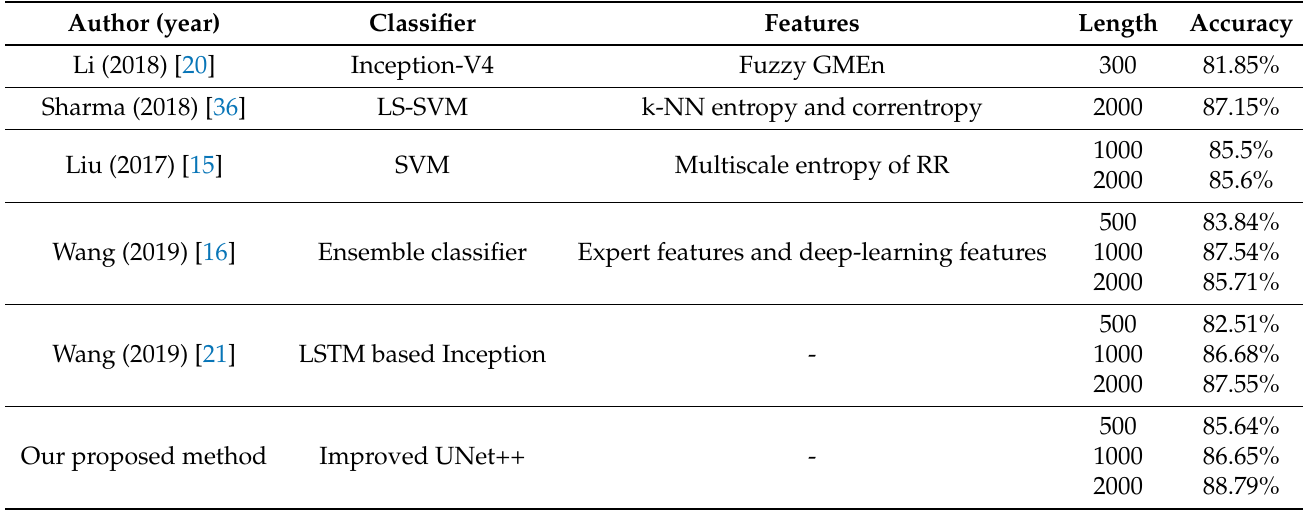
Table 3. Comparison of the proposed method against existing methods on CHF detection.